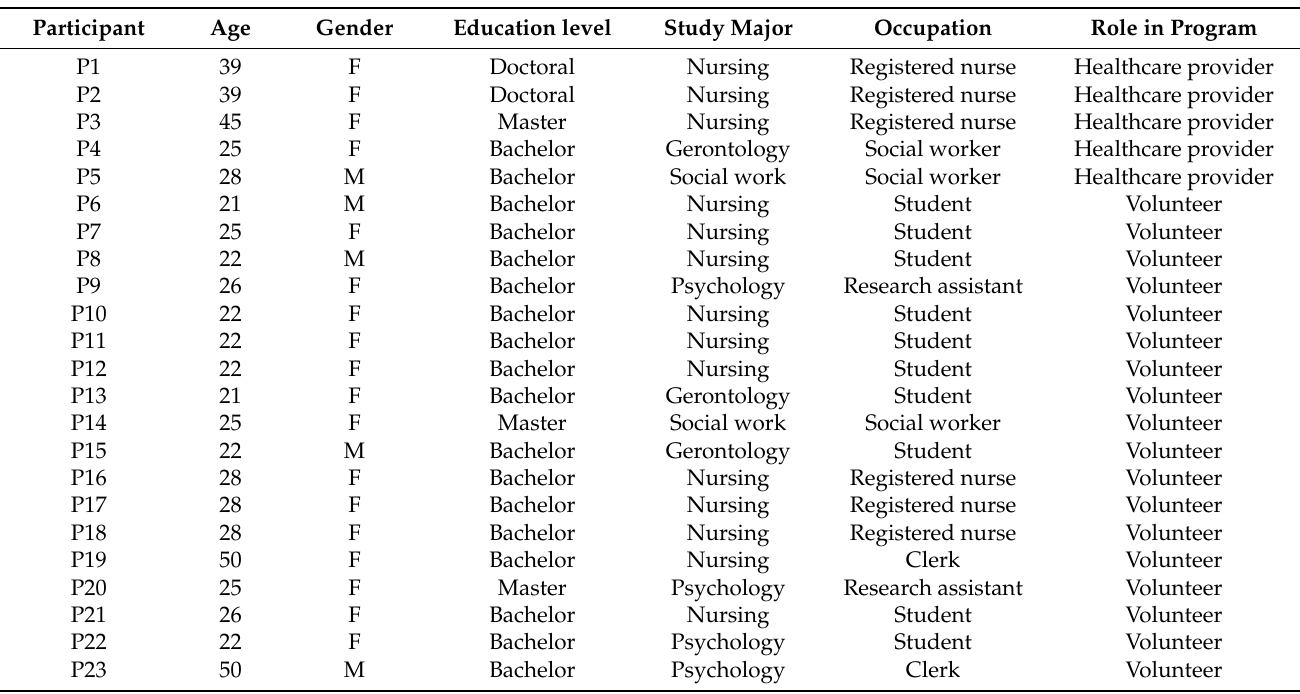
Table 1. Demographic characteristics of the